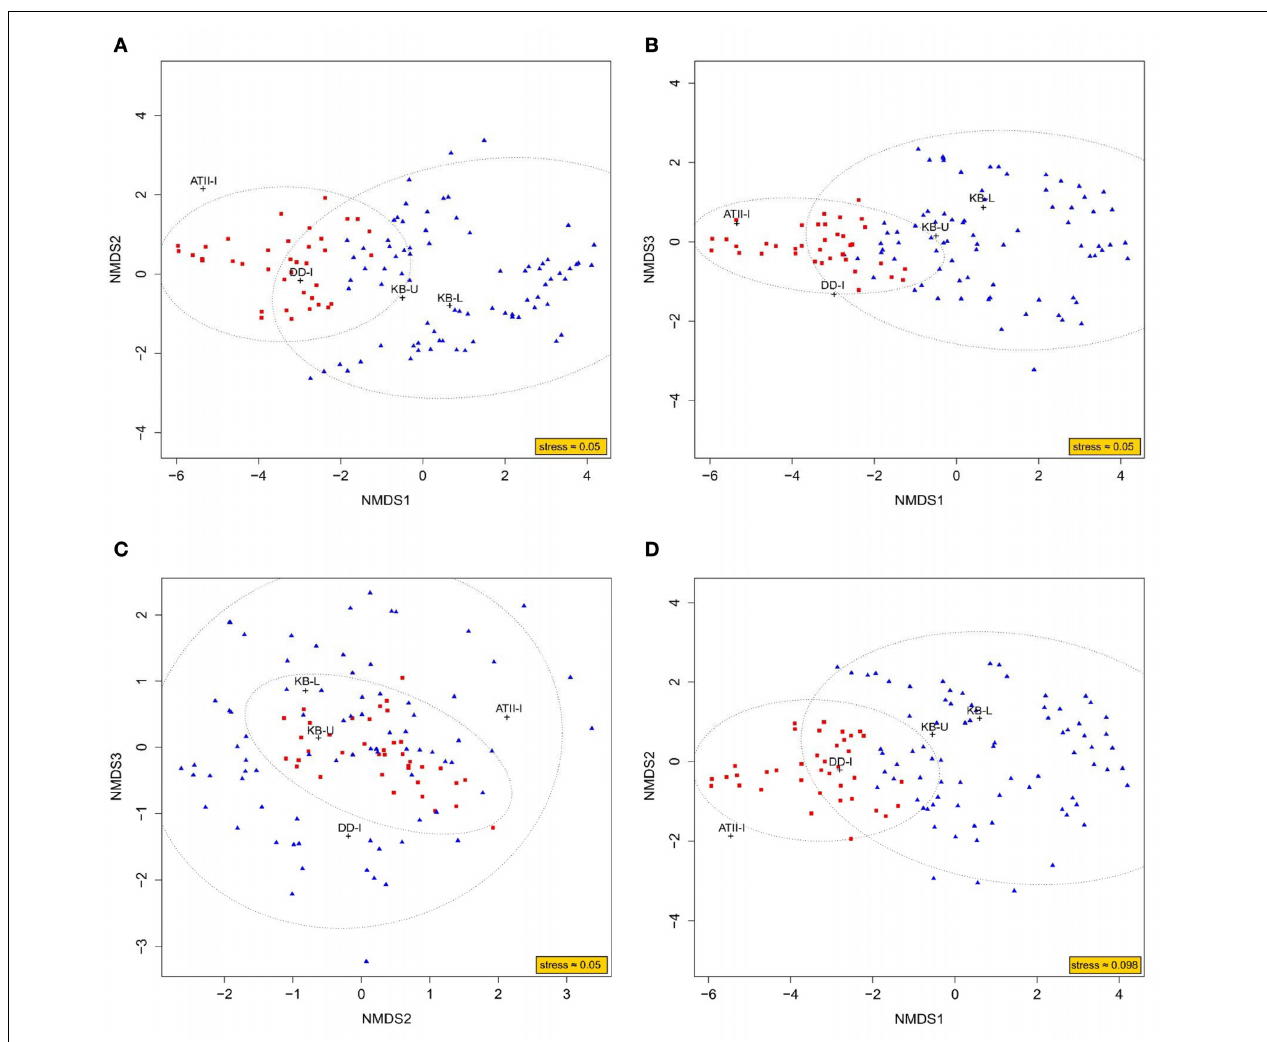
FIGURE 5 | NMDS ordination plot based on KEGG mapping to methane metabolismpathways. RepresentationoftheNMDSanalysisin3D (A–C) and 2D (D) .TheanalysisconsiderseachdatasetofreadsobtainedthroughRedSea interface shotgun pyrosequencing as a variable. The read counts recruited to methanemetabolism-relatedKEGGorthologousgroupswereconsideredasan